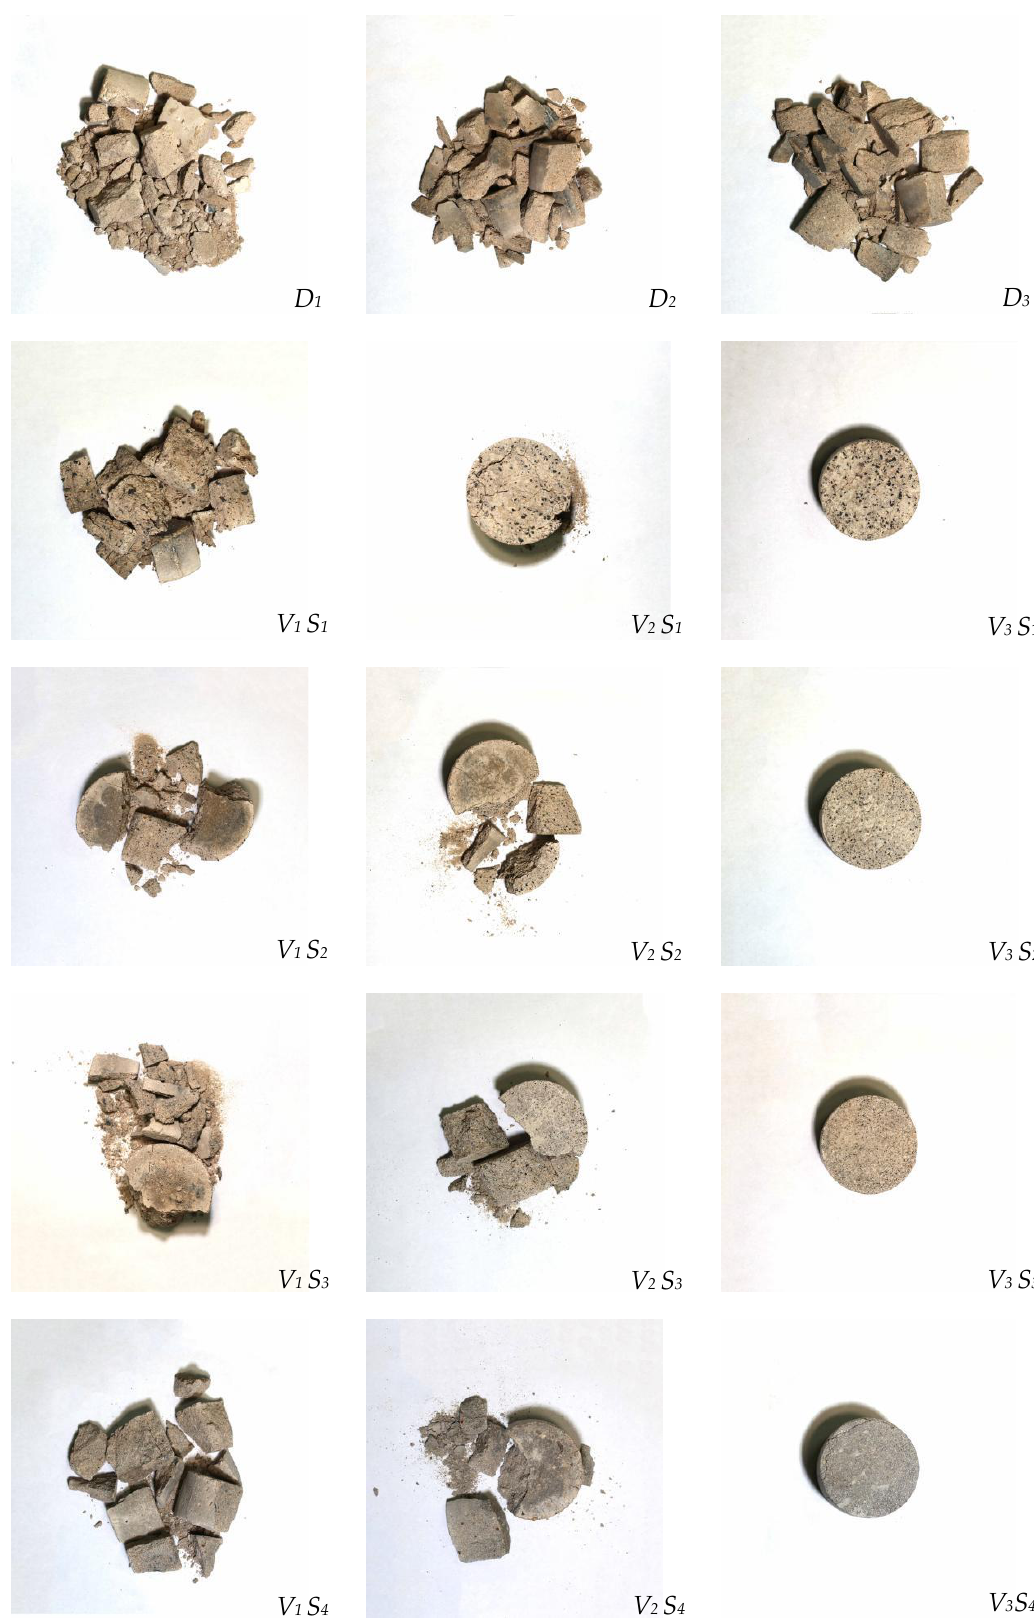
Figure 7. Fracture morphology of RASM specimen.